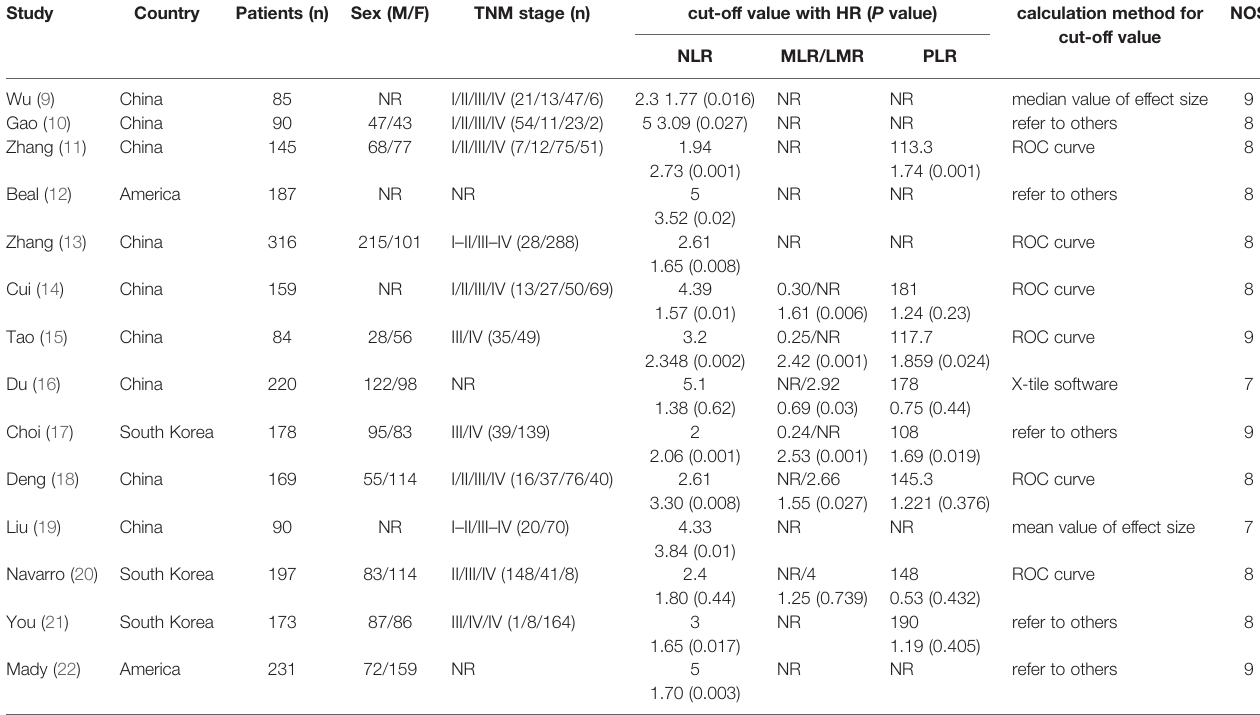
TABLE 1 | Basic characteristics of included